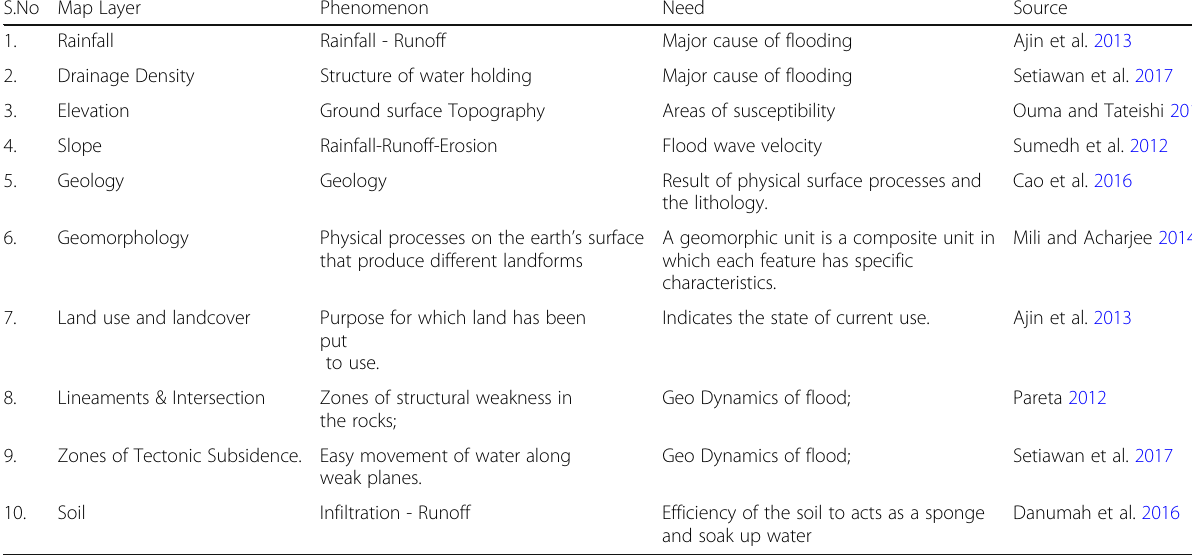
Table 1 Criteria for vulnerable